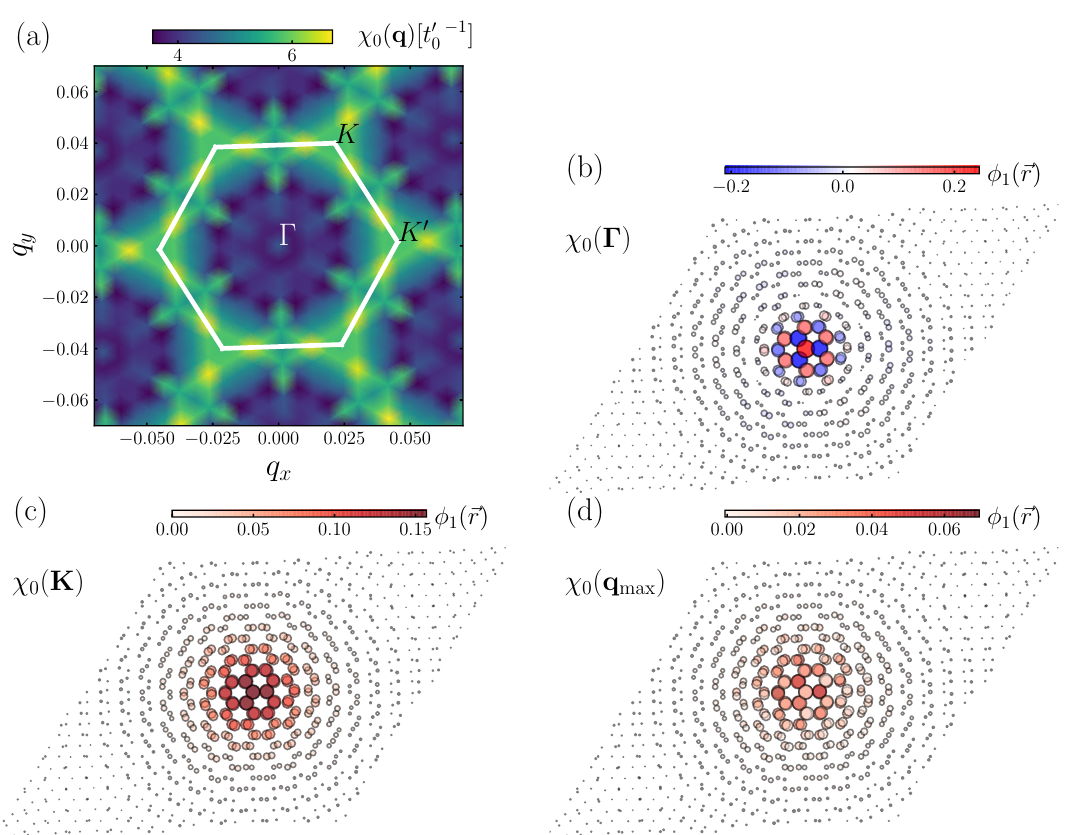
( q ,0 ) of the susceptibility ten- 0 = 1.08 ◦ . The white hexagon denotes the first eff , respectively. We used max , and a total of 200 states k